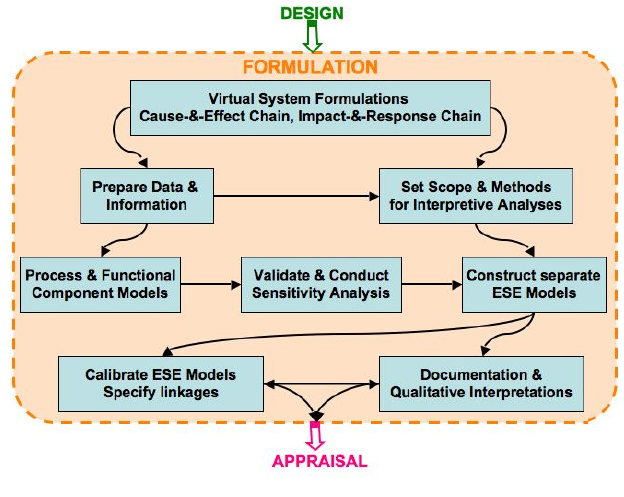
Fig. 7 . Diagram of the activities and products for